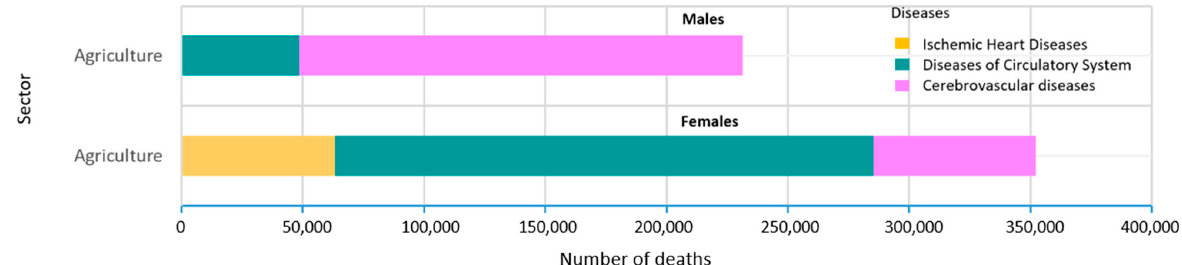
Figure 3. Number of deaths with PMR > 1 in agriculture by diseases and gender (males: 231,155; females: 352,292). The PMR was calculated considering the longest duration of employment. Table 2. Occupational Mortality Matrix (OMM) based on proportional mortality ratios (PMRs) by cause of death and industrial sector for